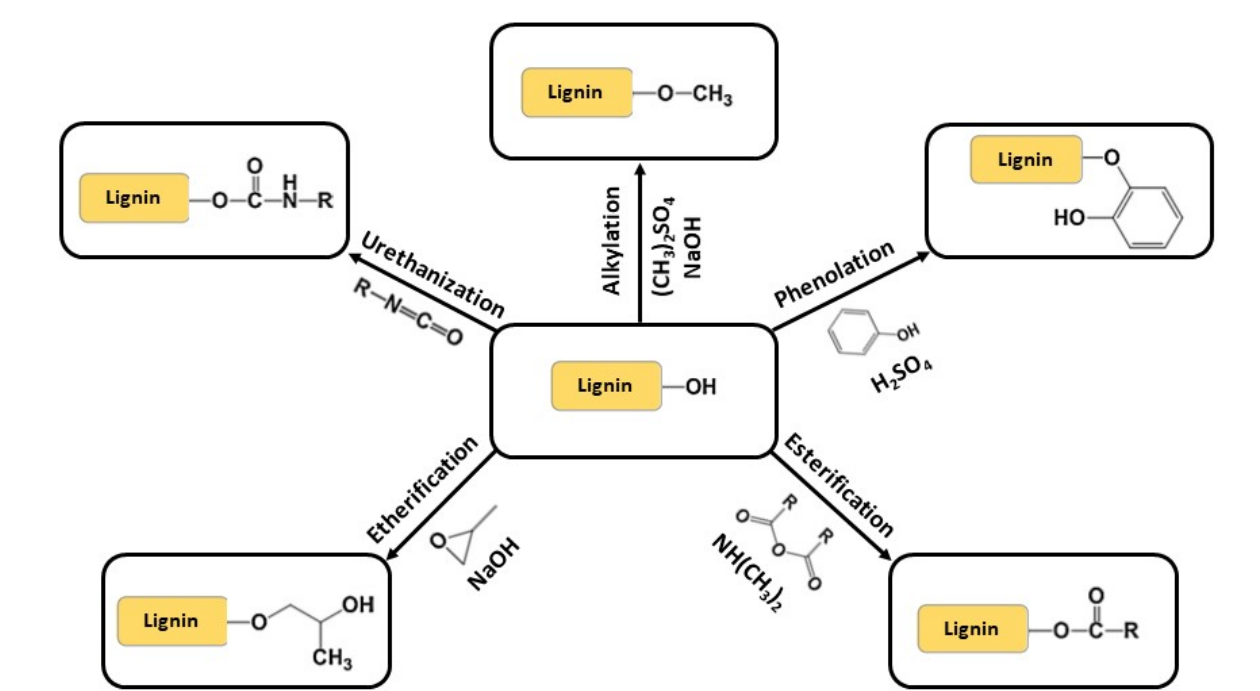
Figure 8. Lignin hydroxyl‑group functionalization.